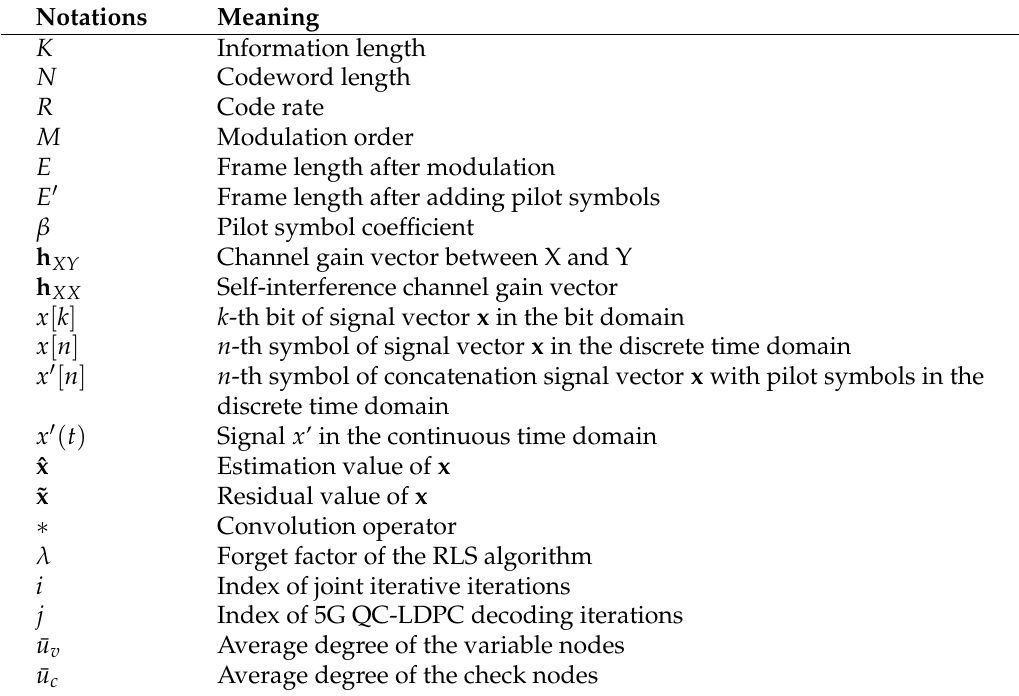
Table 1. List of